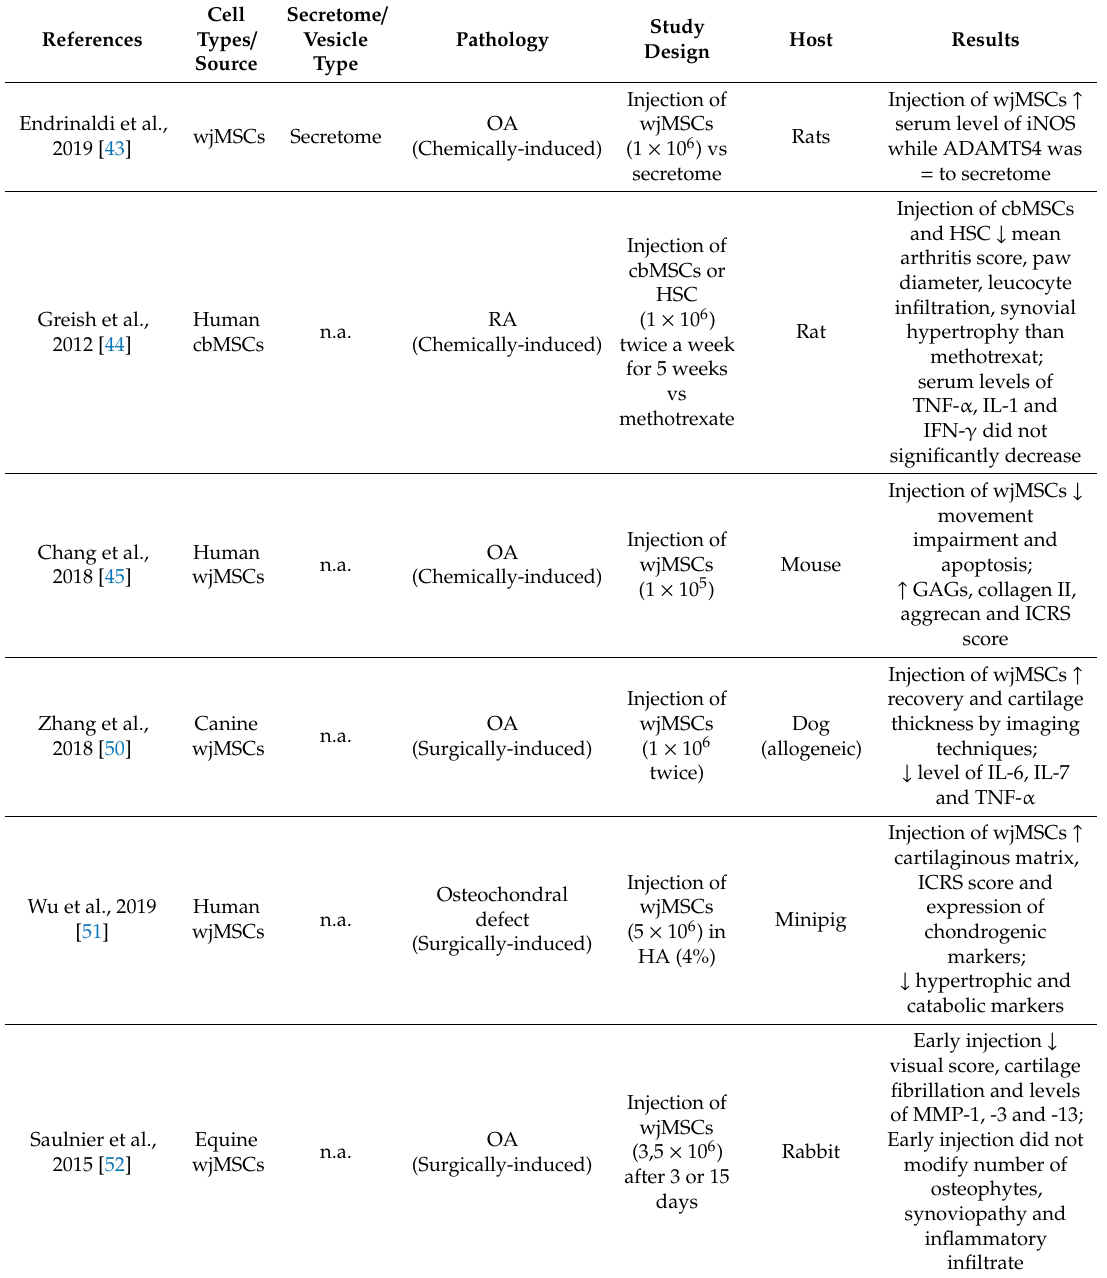
Table 2. Details of the papers that used MSCs from the umbilical cord or their secretome / EVs in the treatment of joint diseases in in vivo models. Abbreviations: wjMSCs: Wharton’s jelly mesenchymal stem cells, OA: osteoarthritis, iNOS: inducible nitric oxide synthase, ADAMTS: a disintegrin-like and metalloproteinase with thrombospondin, cbMSCs: cord blood mesenchymal stem cells, RA: rheumatoid arthritis, HSC: hematopoietic stem cells, TNF- α : tumor necrosis factor-alpha, IL: interleukin, IFN- γ : interferon-gamma, GAGs: glycosaminoglycans, ICRS score: International Cartilage Repair Society score, MMP: matrix metalloproteinase, ucMSCs: umbilical cord mesenchymal stem cells and